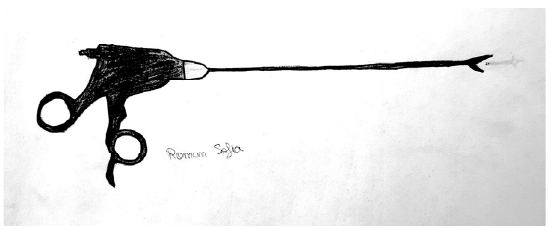
Figure 16. Laparoscopic grasping